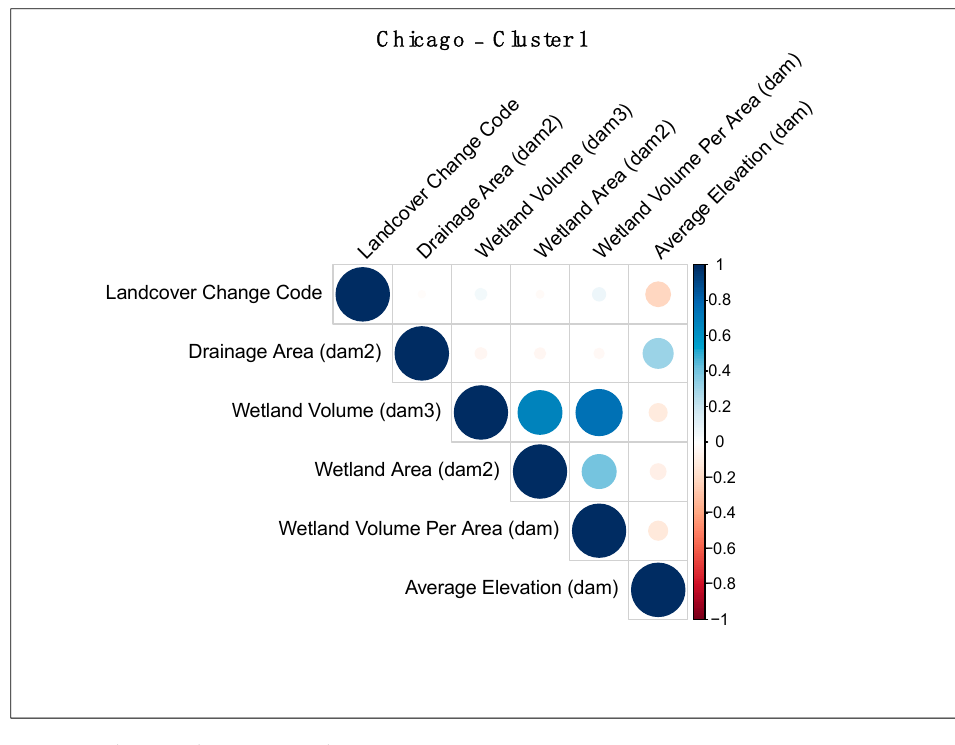
Figure 9. Chicago cluster 1 correlation matrix. The correlation matrix for cluster 2 (Figure 10) shows that (1) landcover change has a negative correlation with average elevation, indicating that wetland areas where more intense landcover change has occurred tend to be located at lower elevations. (2) Drain- age area has a weak positive correlation with wetland volume per area, indicating that in this cluster, more water tends to flow into wetlands with a higher water storage capacity per area. (3). Again, wetland volume, wetland area, and wetland volume per area, are positively correlated with each other.